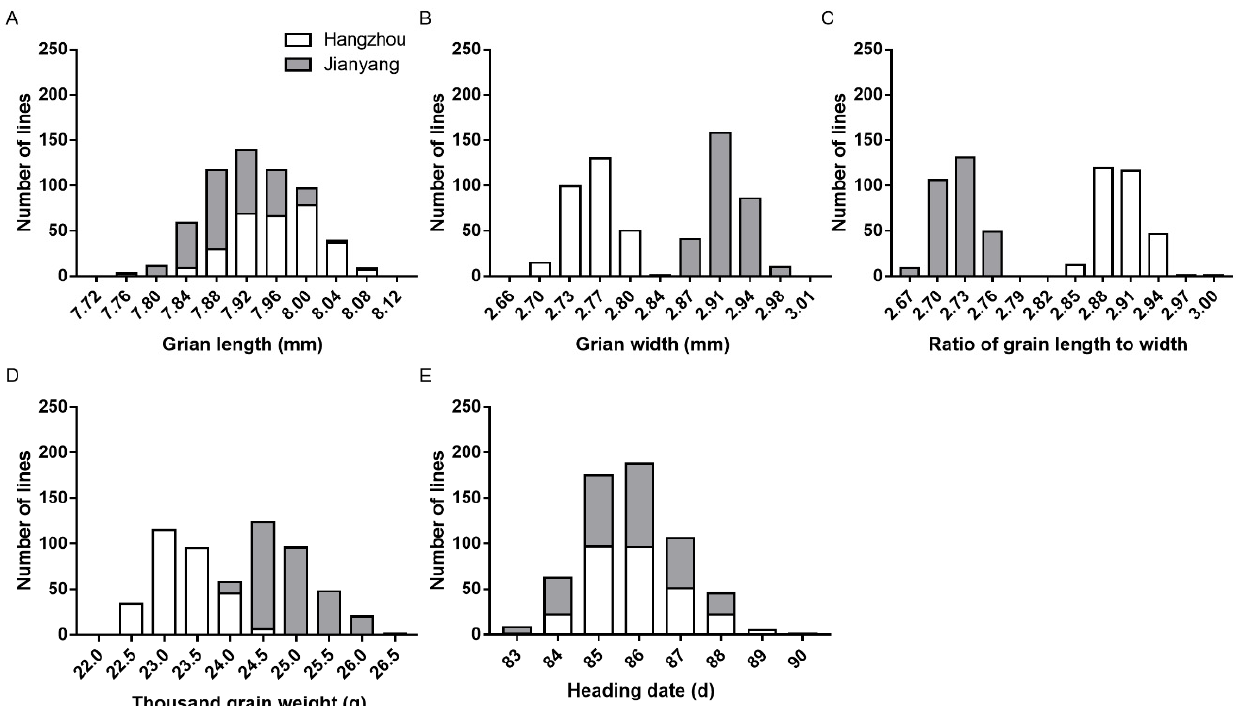
Figure 1. Frequency distribution of five traits in the ZL1 population. ( A ) Grain length. ( B ) Grain width. ( C ) Ratio of grain length to width. ( D ) Thousand grain weight. ( E ) Heading date. Pearson’s correlation analysis between the two trials conducted in different locations showed highly significant ( p < 0.001) correlations for all five traits. The correlation coeffi- cients were 0.476, 0.599, 0.650, 0.700 and 0.335 for GL, GW, RLW, TGW and HD, respectively.